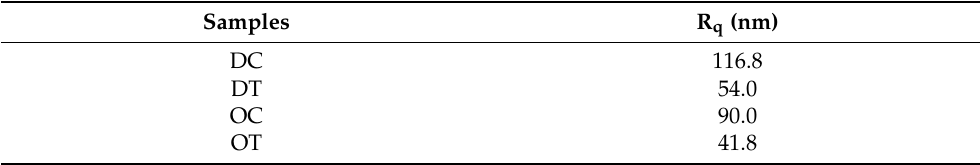
Table 1. R q values for control and plasma-treated wheat seeds.